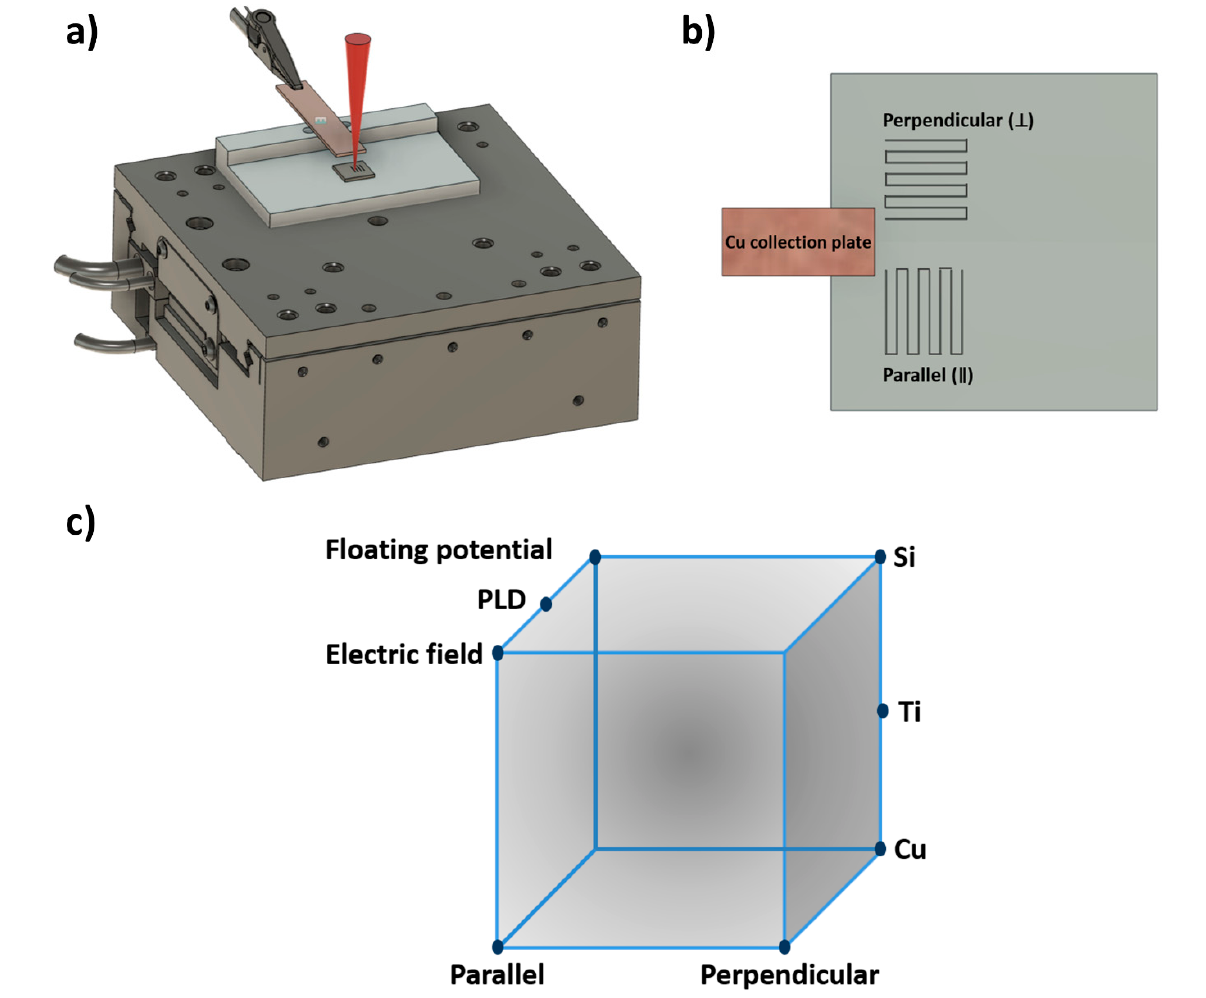
Figure 1. Schematic representation of ( a ) the nanoparticle collection setup, ( b ) the raster laser scanning directions, and ( c ) the experimental space.